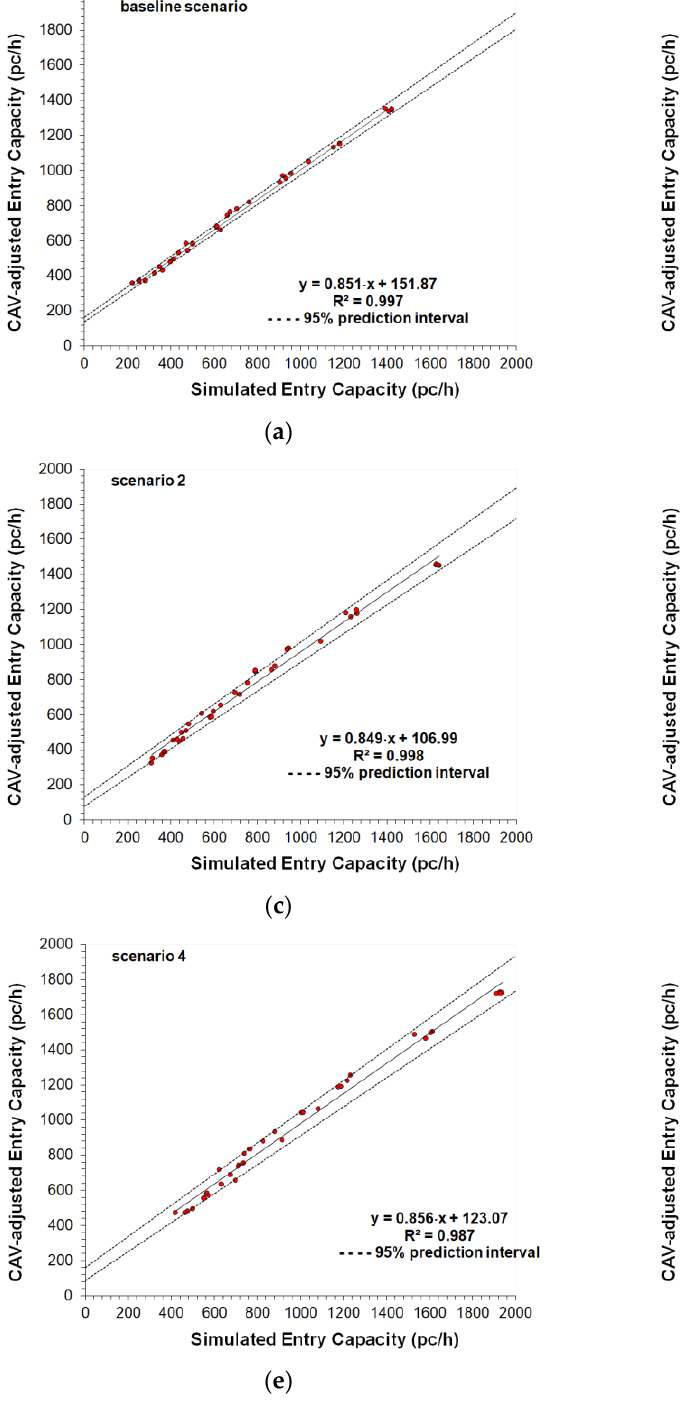
Figure 8. Scattergram analysis to compare the CAV-adjusted versus simulated entry capacity data for different proportion of CAVs and HDVs for the entry mechanism 2 (i.e., the left entry lane of two-lane entry approach conflicted by two circulating lanes) listed as: ( a ) baseline scenario: 0% CAVs and 100% HDVs; ( b ) scenario 1: 20% CAVs and 80% HDVs; ( c ) scenario 2: 40% CAVs and 60% HDVs; ( d ) scenario 3: 60% CAVs and 40% HDVs; ( e ) scenario 4: 80% CAVs and 20% HDVs; ( f ) scenario 5: 100% CAVs and 0% HDVs. Note: to explain the entry mechanisms 2 reference has been made to the northbound left entry lane entry in Figure 4a.